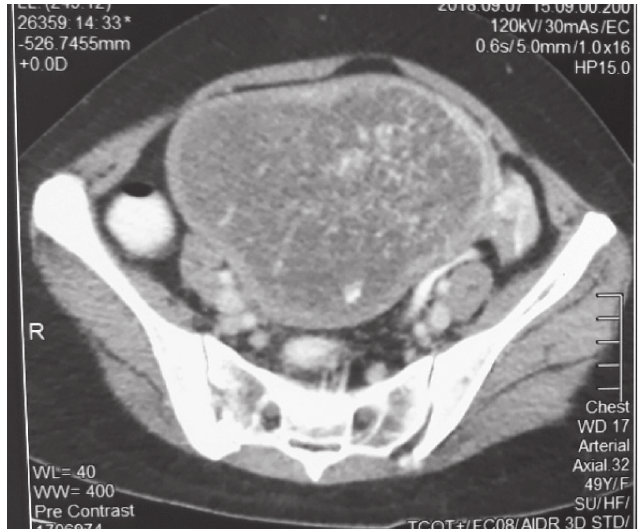
Figure 2: Contrast-enhanced CT appearance of the hydatidiform mole.